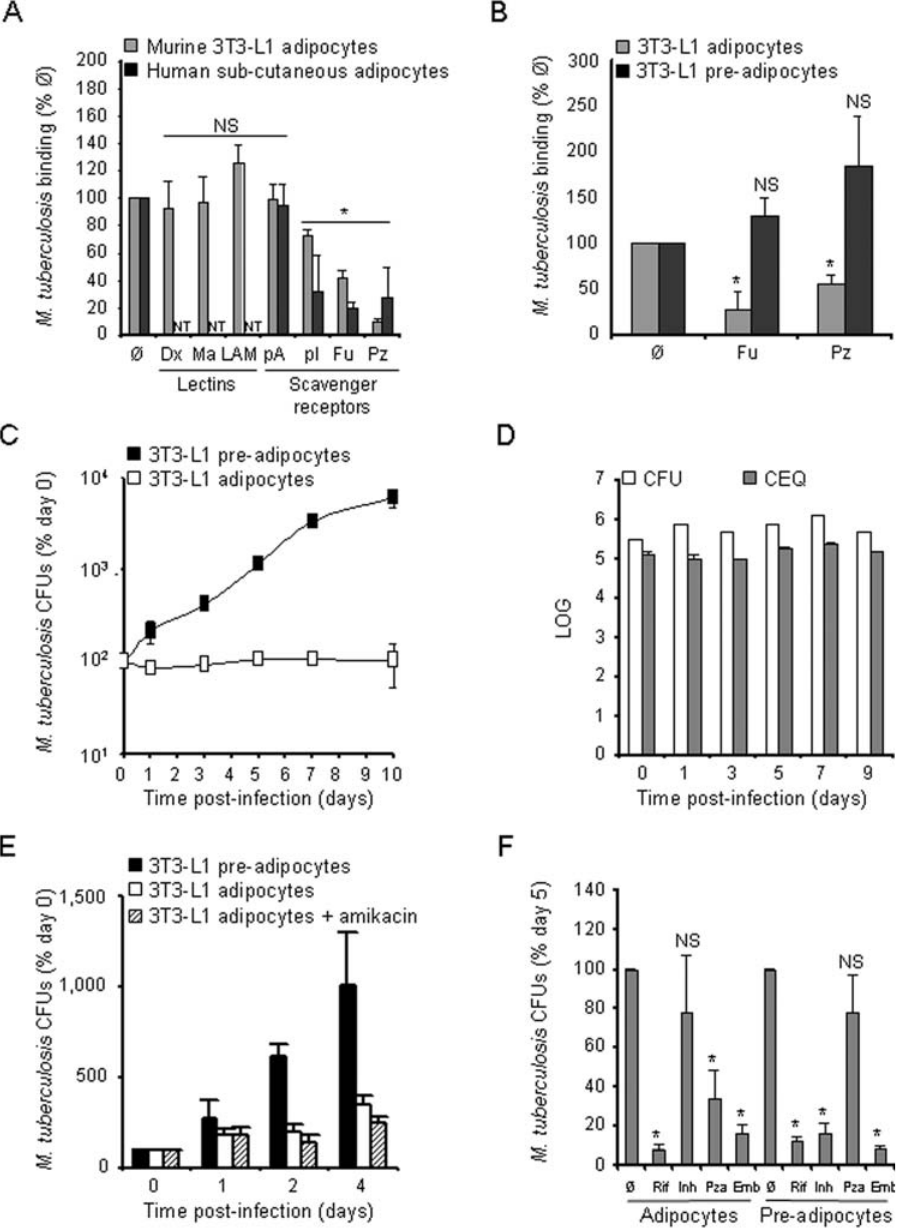
Figure 1. M.tuberculosispersists in a non-replicating state inside adipocytes. A. 3T3-L1 mouse (grey bars) and primary human (black bars) adipocytes were infected with M. tuberculosis , clinical isolate MT103, at a MOI of 1. Mycobacterial binding to the cells was measured after 4 h at 4 u C in the presence of various inhibitors. Man, yeast mannan; LAM, lipoarabinomannan; pA, polyadenosinic acid; pI, polyinosinic acid; Fuc, fucoidan; PC, PAz- PC, a predominant form of oxidized low-density lipoprotein. Results are expressed as % of the binding without inhibitor (Ø). B. 3T3-L1 adipocytes (grey bars) and pre-adipocytes (black bars) were infected as described in A. in the presence of Fuc or PAz-PC. Mycobacterial binding was assessed and analysed as in A. C. 3T3-L1 pre-adipocytes (black squares) and adipocytes (open squares) were pulsed with M. tuberculosis MT103 at a MOI of 1 for 4 h at 37 u C, then chased with fresh medium. Mycobacterial survival, expressed as % of the bacterial load at day 0, was monitored on a 10-day period. The results are standardized as % of the bacterial load at day 0 because of the differential M. tuberculosis binding to adipocytes and pre-adipocytes. D. 3T3-L1 adipocytes were infected as described in C. Viable counts (CFU) were quantified by plating serial dilutions of cell lysates (open bars), and total counts (CEQ) were quantified by qPCR (grey bars). E. 3T3-L1 adipocytes were infected as described in C. In order to kill extra-cellular bacteria cells were pre-incubated with 200 m g/ml amikacin 2 h prior lysis and plating. Results are expressed as % of bacterial load at day 0. F. 3T3-L1 adipocytes and pre-adipocytes were infected as described in C. Cells were treated with 1 m g/ml rifampicin (Rif), 0.1 m g/ml isoniazid (Inh), 25 m g/ml pyrazinamide (Pza) or 5 m g/ml ethambutol (Emb) at day 3, and bacterial loads were quantified at day 5. Results are expressed as % of bacterial load at day 5 in the absence of antibiotics (Ø). In all panels, results are the mean of three independent experiments and bars indicate 6 sd. NT, not tested; NS, not significant, and *, p , 0.05, as assessed by Mann-Whitney test of median comparison.